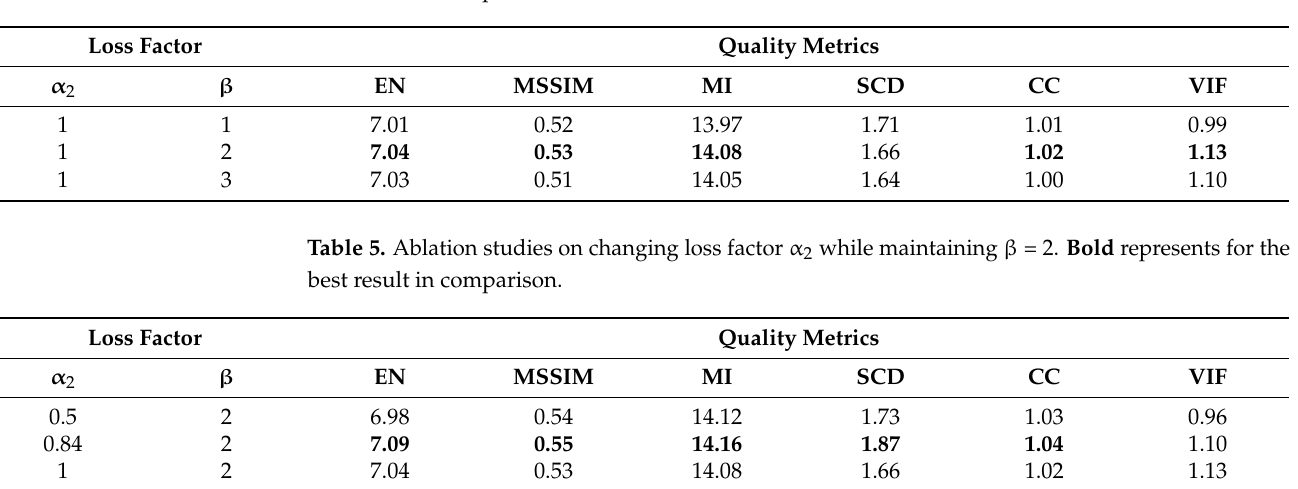
Table 4. Ablation studies on changing loss factor β while maintaining α 2 = 1. Bold represents for the best result in comparison.